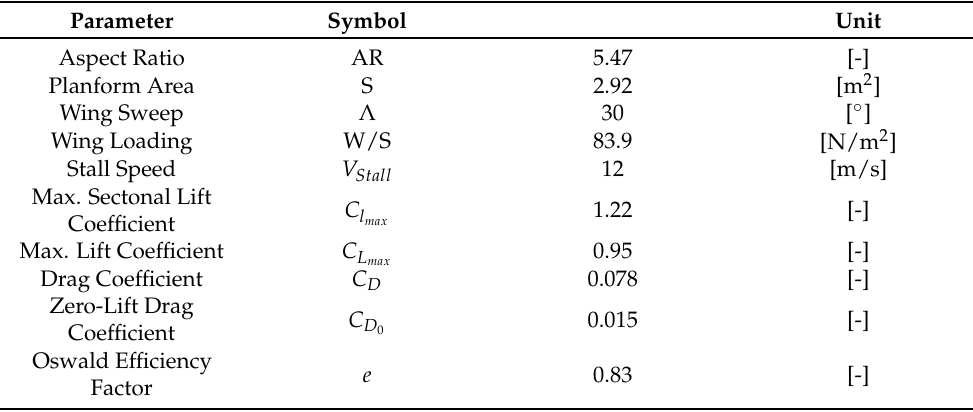
Table 5. Initial Aerodynamic Sizing